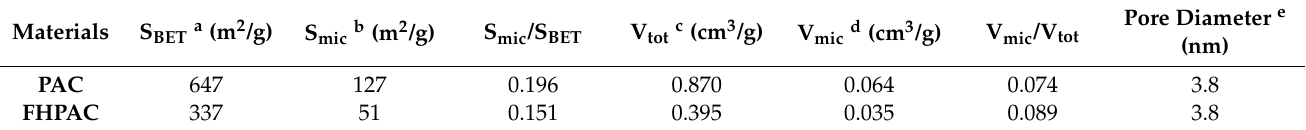
Table 1. Surface area and porosity analysis of PAC and FHPAC.